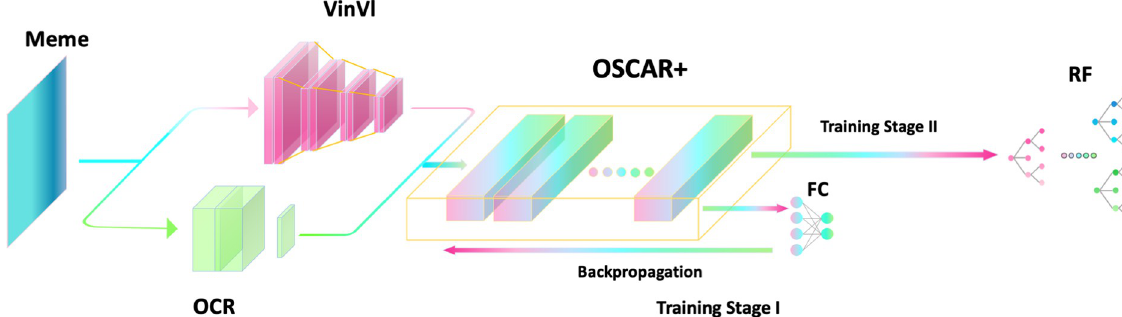
Fig 2. Full pipeline. FC denotes Fully-Connected network; RF denotes random forest classifier.